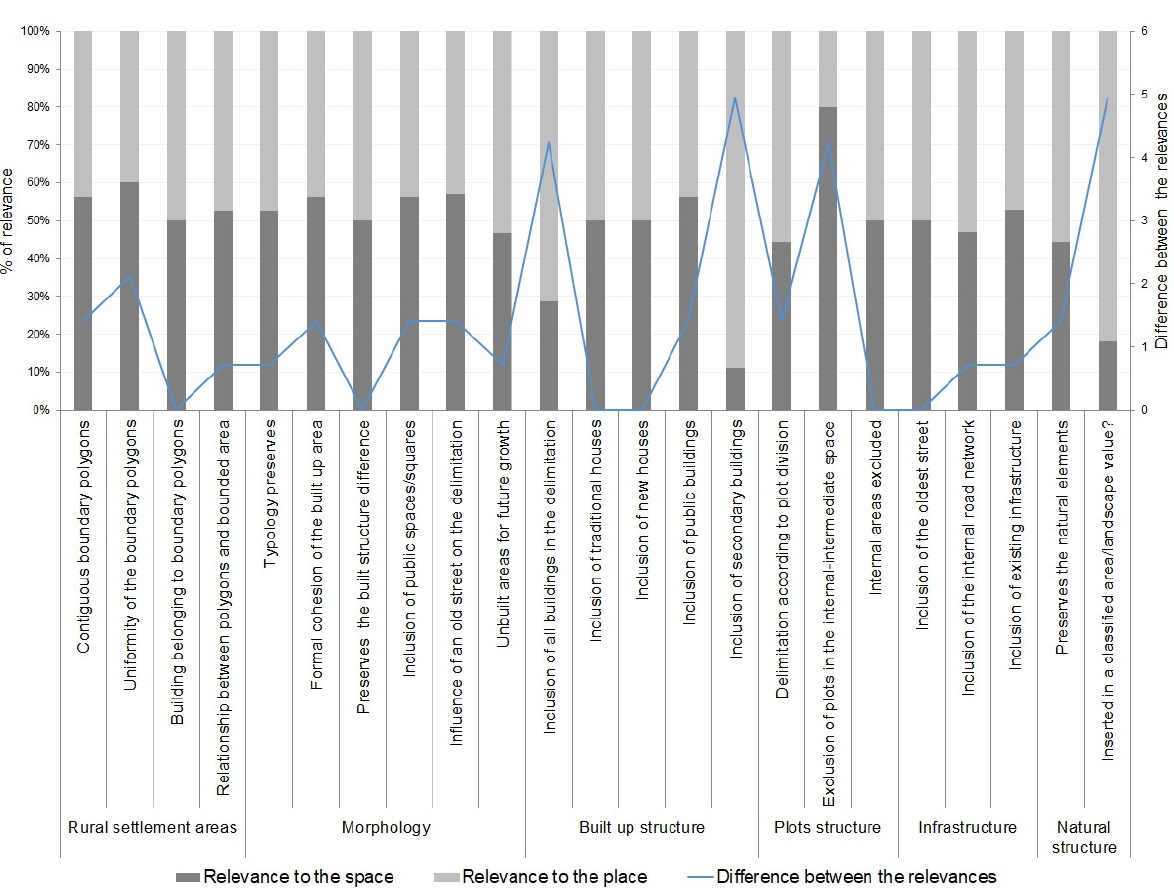
Figure 3. Factors for spatial characterization of a RS. Source: Authors.